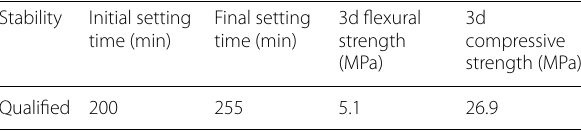
Table 2 The physical and mechanical properties of